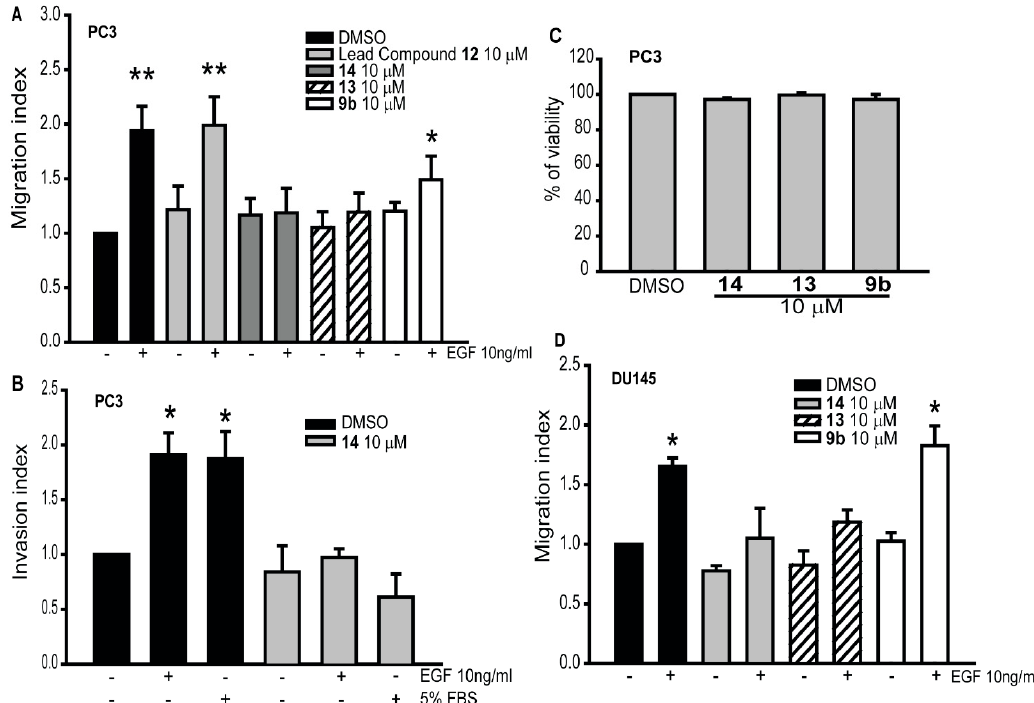
Figure 3. Migratory and invasive capability of prostate cancer cells is differently modulated by the new G α i 2 small molecules inhibitors. ( A ) PC3 cells were incubated with or without the lead compound and three different inhibitors ( 9b , 13 and 14 ) at the final concentration of 10 μ M, and then subjected to transwell migration assays in the presence (+) or absence ( ‐ ) of the epidermal growth factor (EGF) (10 ng/mL). The results are expressed as migration index. Each bar represents mean ± SEM. ( B ) The invasive behavior of PC3 cells treated with or without compound 14 at the final concentration of 10 μ M in the presence (+) or absence ( ‐ ) of EGF (10 ng/mL). The results are expressed as invasion index. Each bar represents mean ± SEM. 5% FBS was used as positive control. ( C ) PC3 cells were treated with the inhibitors, at a final concentration of 10 μ M. MTS assays were conducted, and the results were expressed as % of viable treated cells against the control cells. Each bar represents mean ± SEM. ( D ) DU145 cells were incubated with or without the three inhibitors ( 9b , 13 and 14 ) at the final concentration of 10 μ M, and then subjected to transwell migration assay in the presence (+) or absence ( ‐ ) of EGF (10 ng/mL). Results are expressed as migration index. Each bar represents mean ± SEM (* p ≤ 0.05; ** p ≤ 0.01).